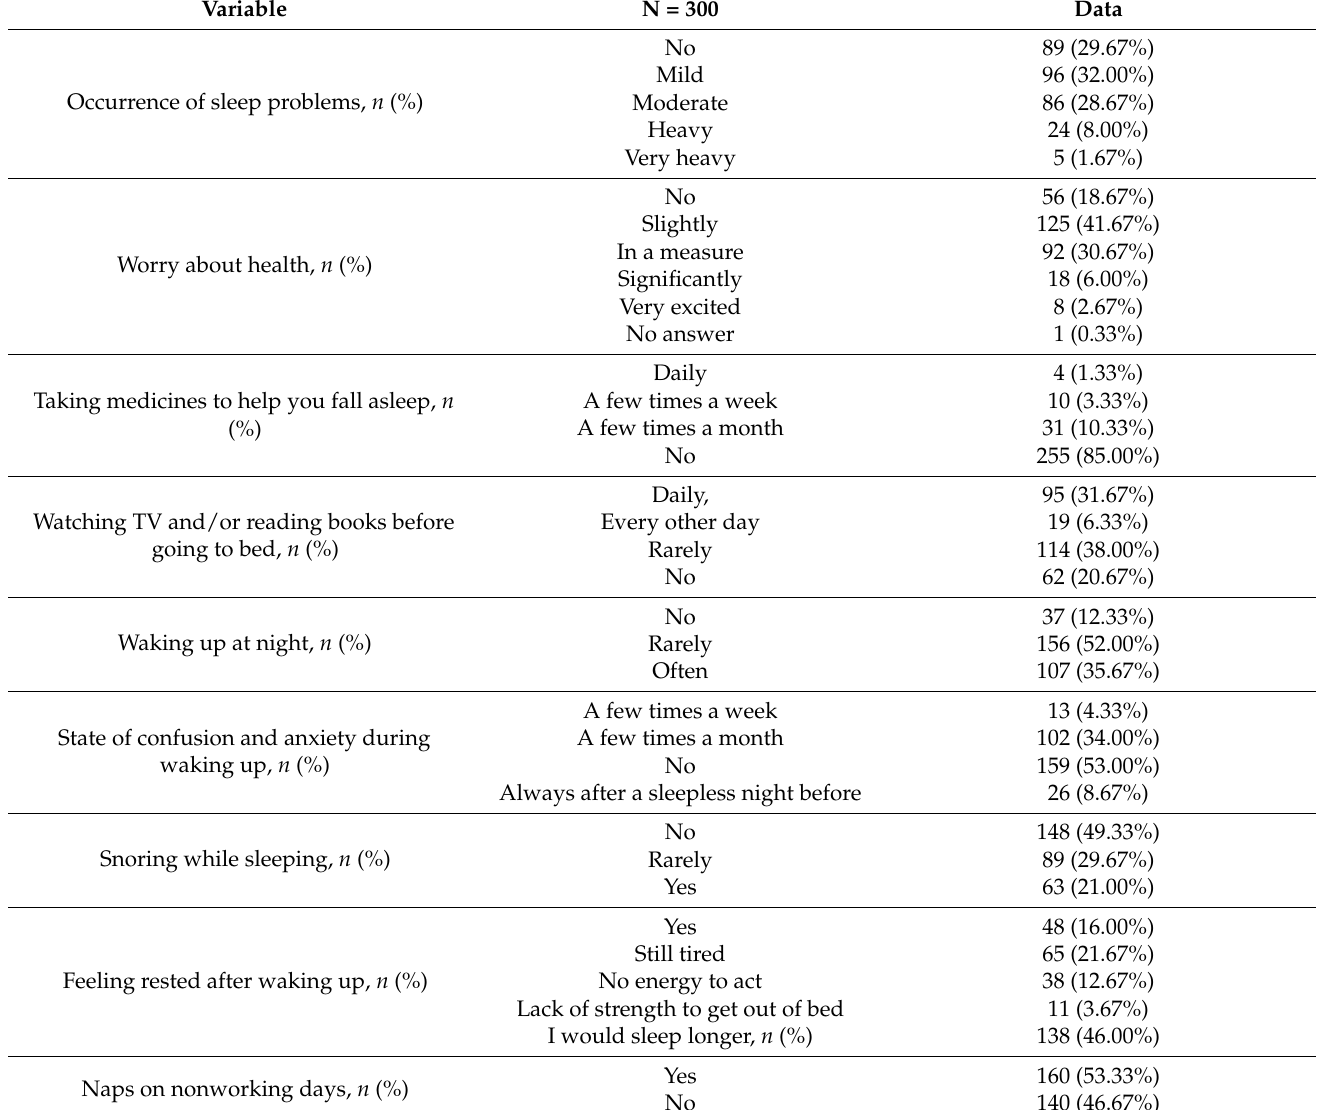
Table 3. Characteristics of the quality of